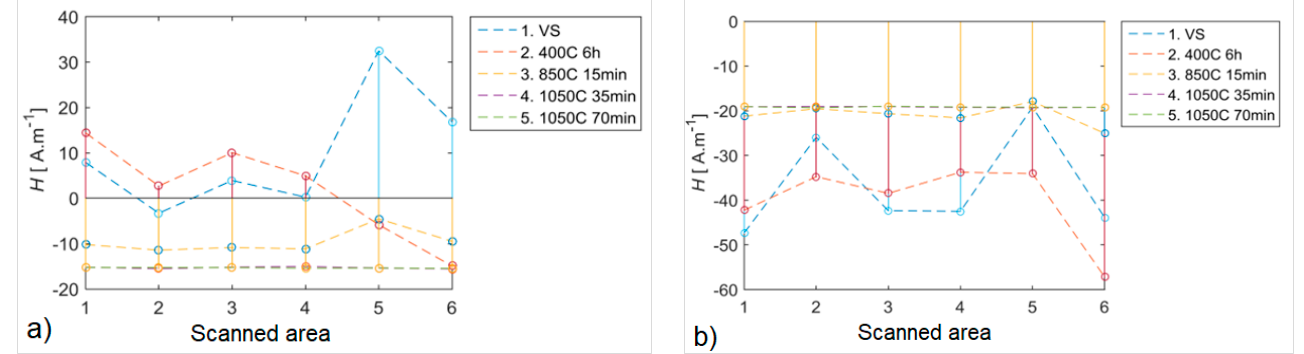
Figure 10. Comparison of ( a ) maximum and ( b ) minimum values on the scanned surfaces of all specimens.